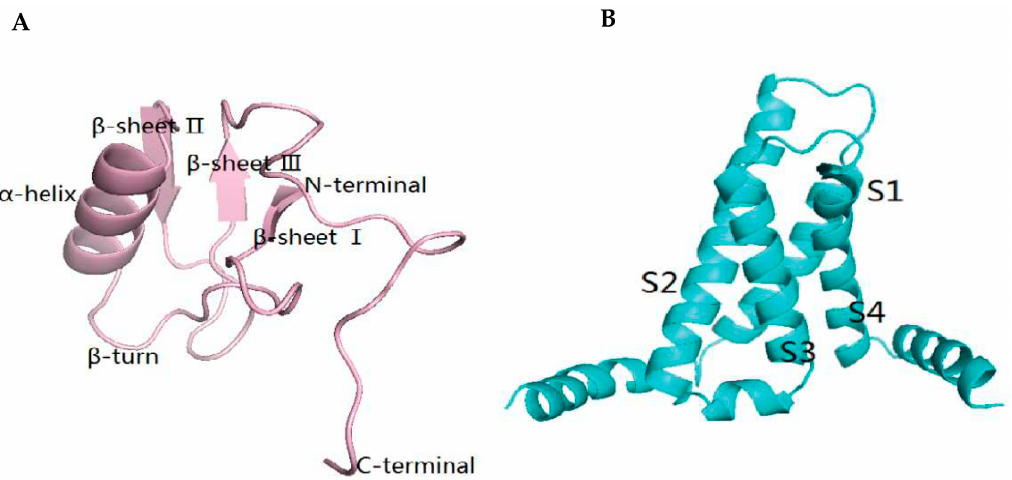
Figure 8. ( A ) Homology modeling of Syb-prII-1. ( B ) Homology modeling of VSD2 rNav1.8 .